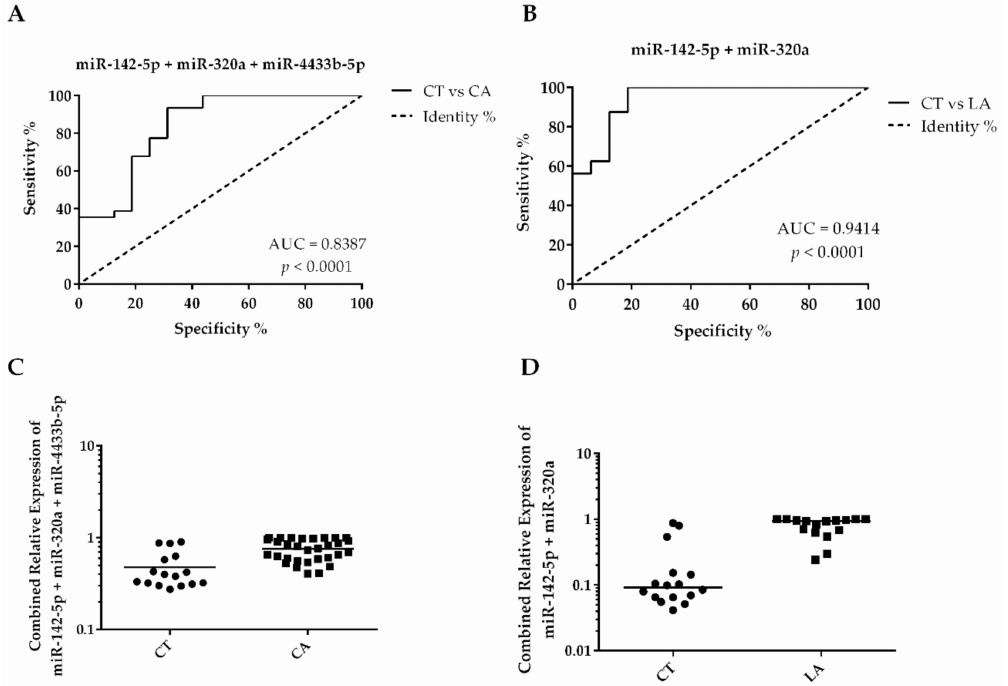
Figure 6. Combined ROC curves and scatter plots indicating diagnosis potential of EV-miRNAs panels. ( A ) ROC curve calculated combining miR-142-5p, miR-320a, and miR-4433b-5p to diagnose BC. ( B ) Panel combining miR-142-5p and miR-320a showing excellent accuracy to diagnose LA patients. ( C ) Control (CT) and cancer (CA) distribution after binary logistic regression analysis combining relative quantification (RQ) values of miR-142-5p, miR-320a, and miR-4433b-5p. ( D ) CT and luminal A (LA) distribution after binary logistic regression combining RQ values of miR-142-5p and